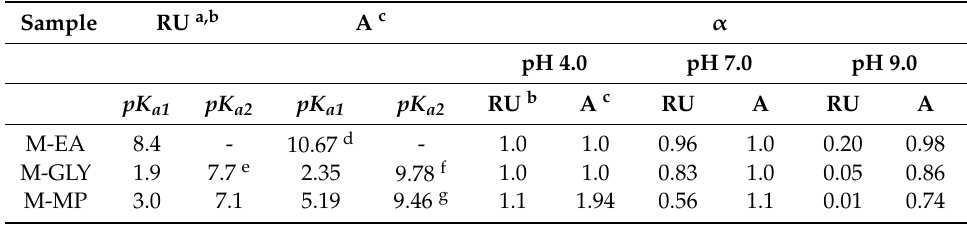
Table 6. Protonation degree ( α ) of polymer repeat units and parent